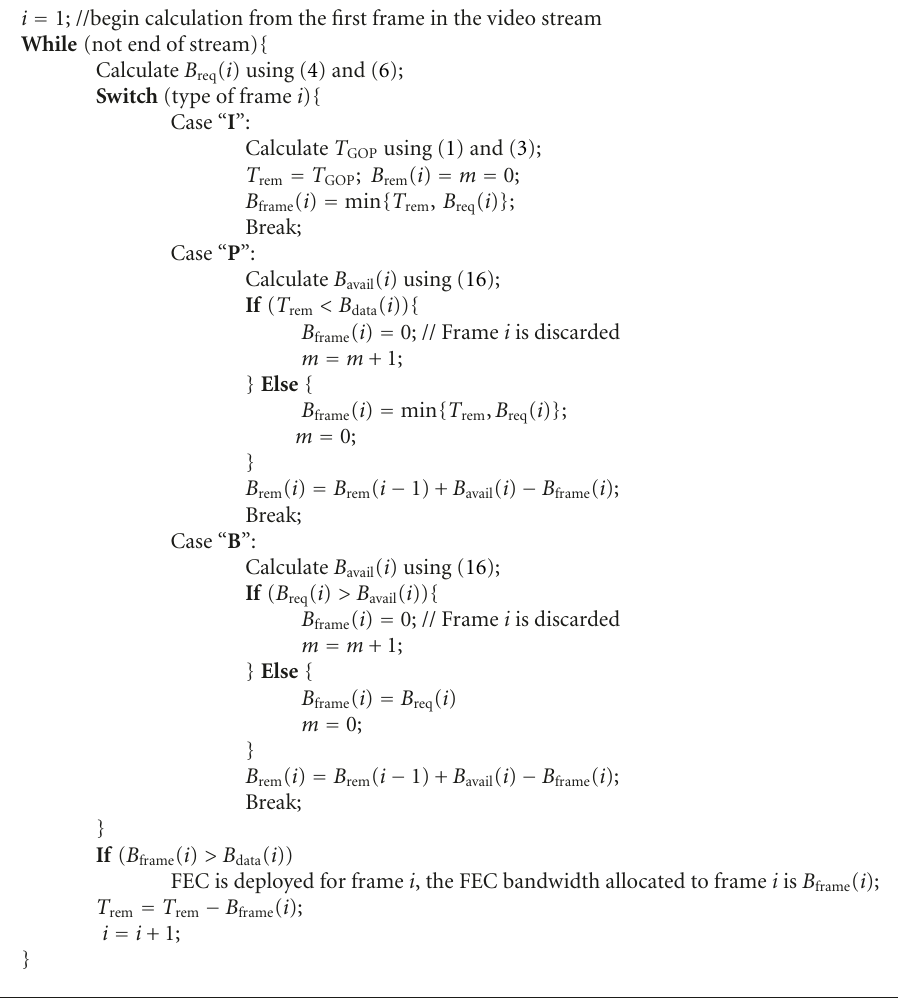
Algorithm 1: Adaptive rate allocation algorithm.